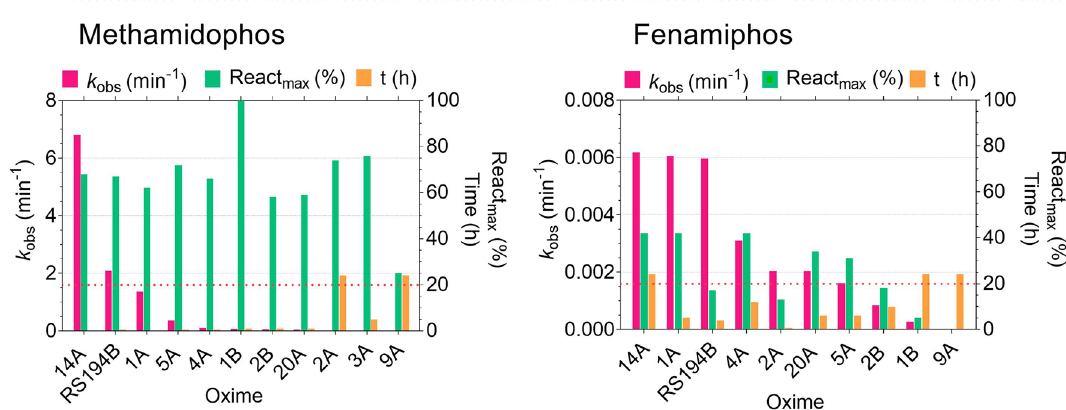
Figure 5. Reactivation screening of pesticide-inhibited hAChE by selected oximes (0.1 mM) measured at 25 °C. Results are expressed as means of the observed reactivation rates ( k obs ), maximal reactivation percentages and time to achieve maximum of reactivation determined from at least three